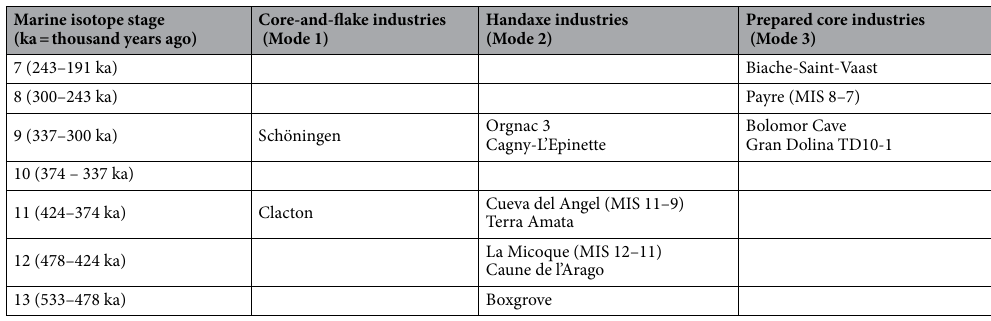
Table 2. European Lower and early Middle Palaeolithic sites 17,18,20,21,71,88 with soft hammers/retouchers associated with different lithic technologies. The transition from the Acheulean to prepared core and Mousterian technologies is marked by an increased use and abundance of soft organic knapping tools